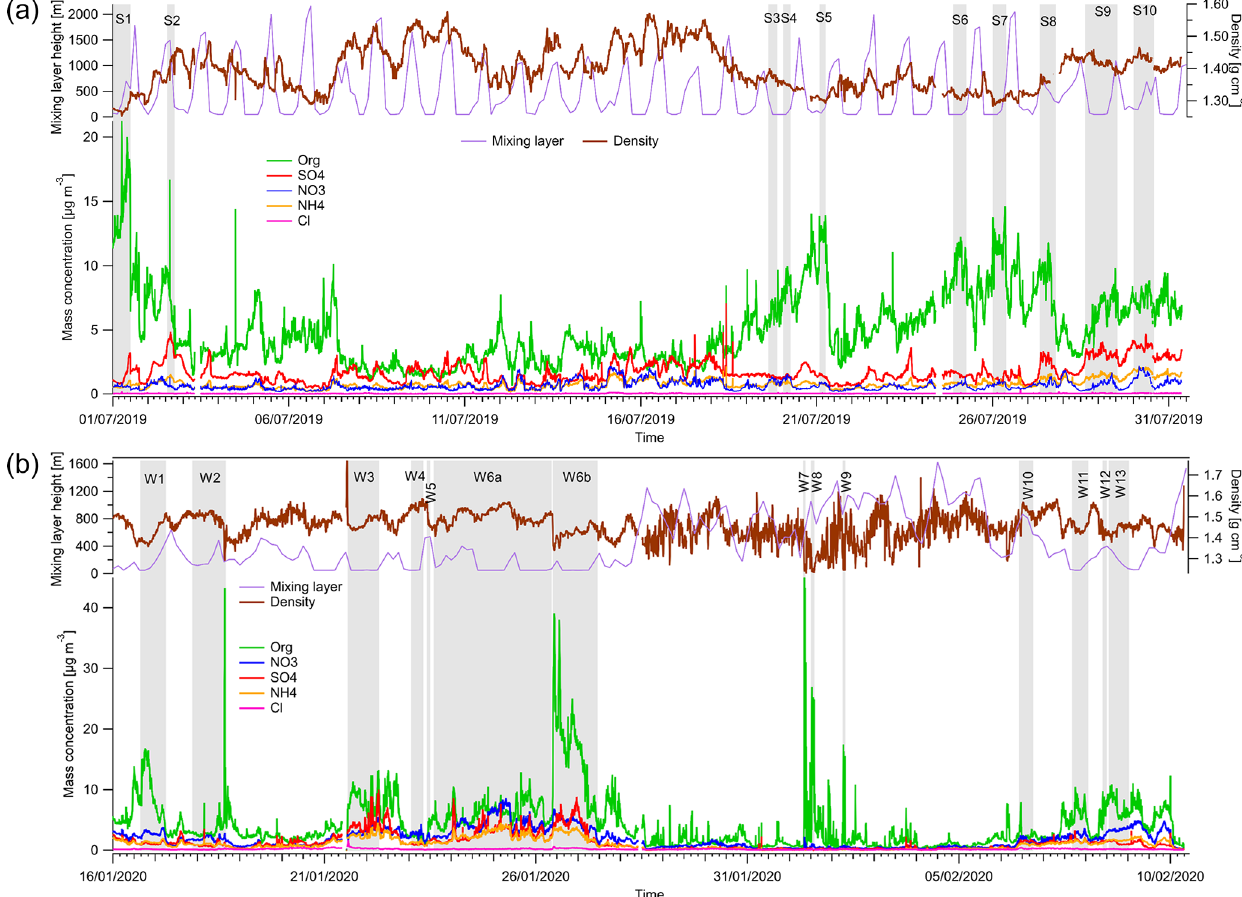
− , SO 2 − , and NH + measured by AMS with applied constant CE correction for summer (a) 3 4 4